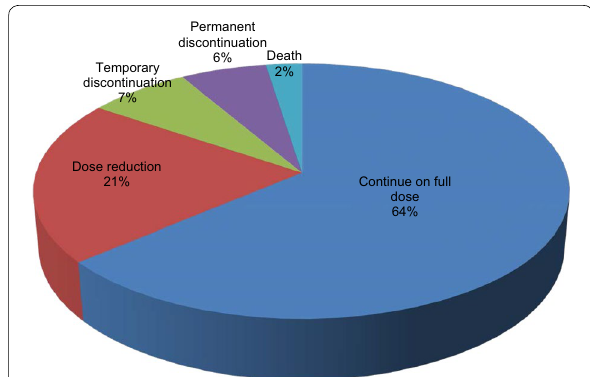
Fig. 2 The impact of each individual adverse event on nintedanib treatment